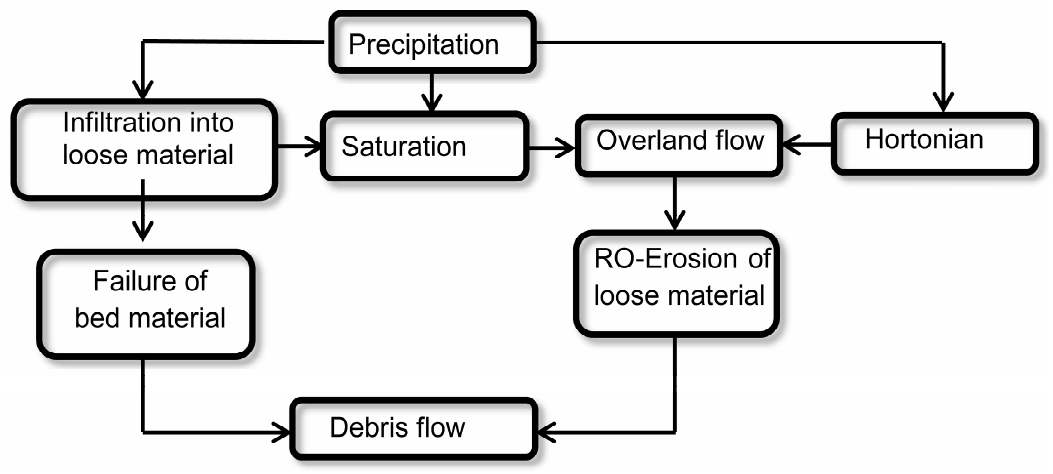
Figure 3. Schematic diagram showing the different initiation processes of debris flows in channels.